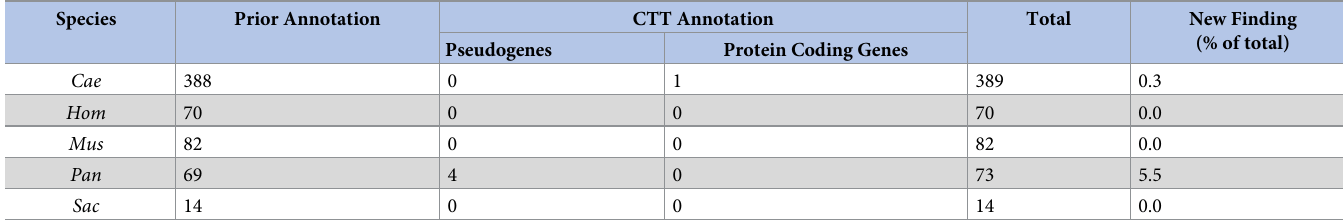
Table 5. CTT annotation of F-box genes in 5 non-plant genomes. Species Prior